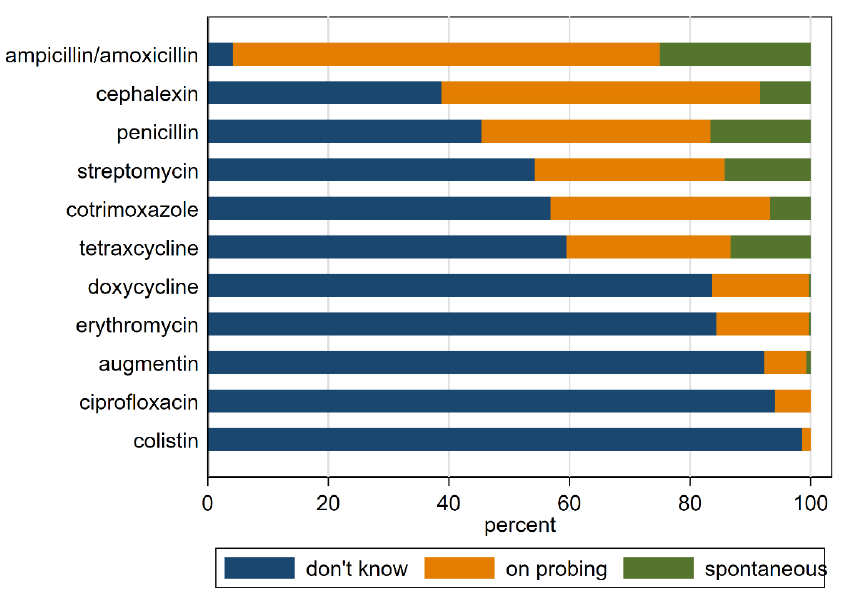
Figure 4. Antibiotic knowledge.